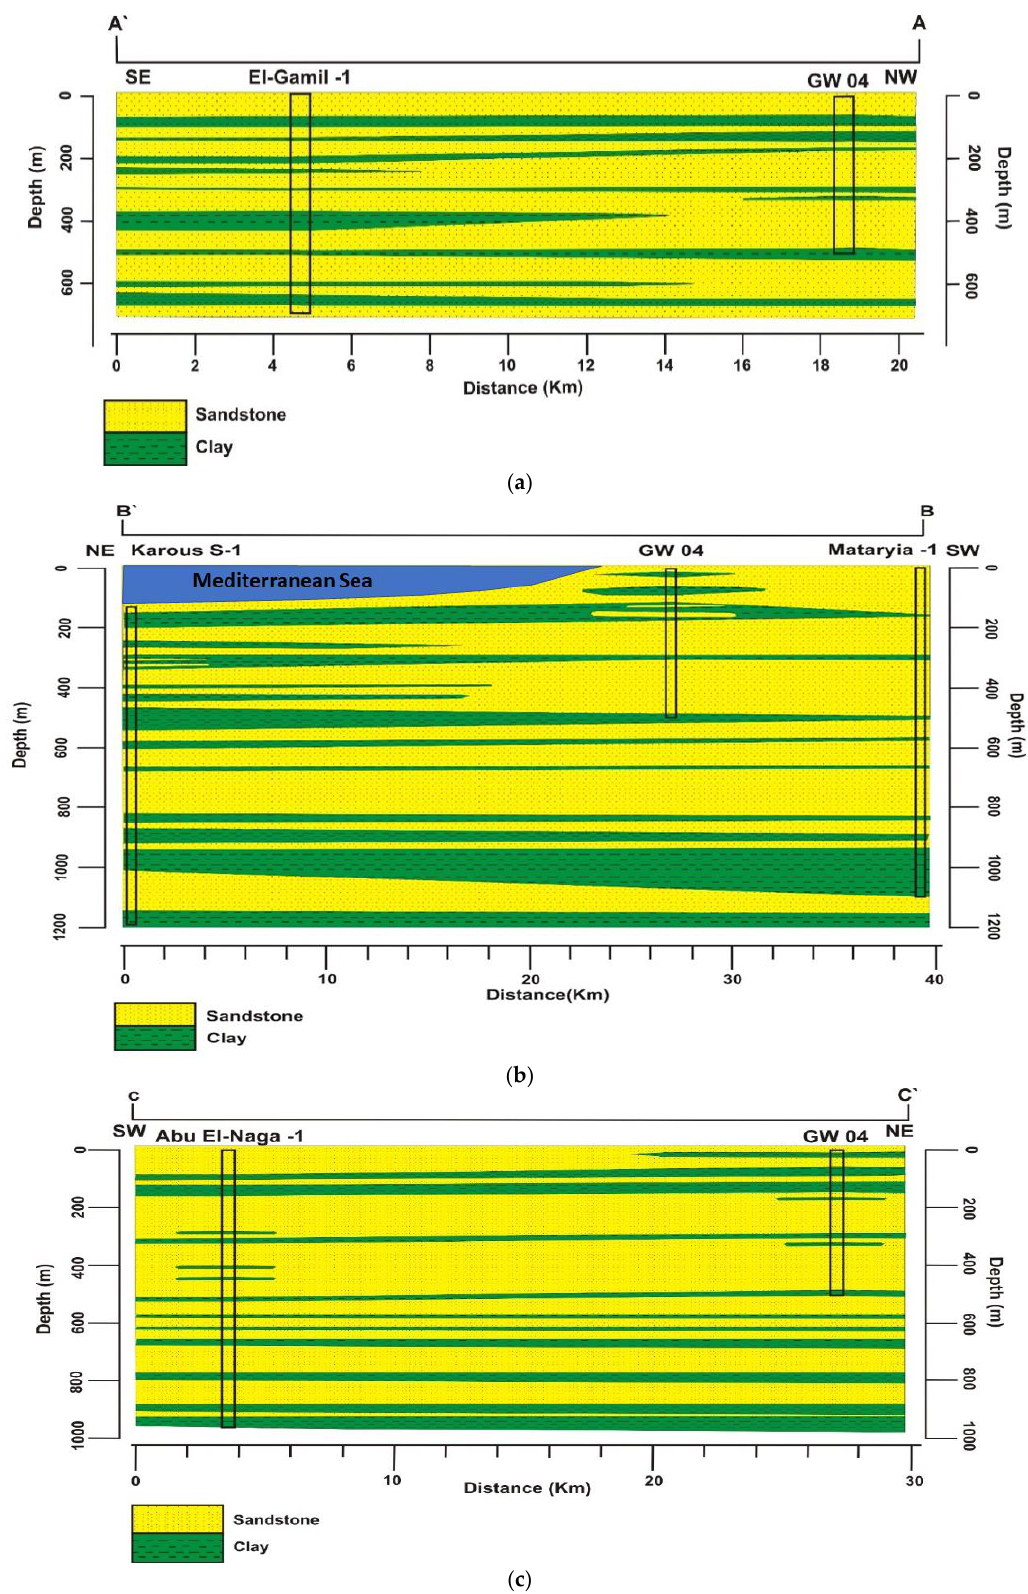
Figure 4. Subsurface geological cross sections: ( a ) A – A`, ( b ) B – B` and ( c ) C – C`.